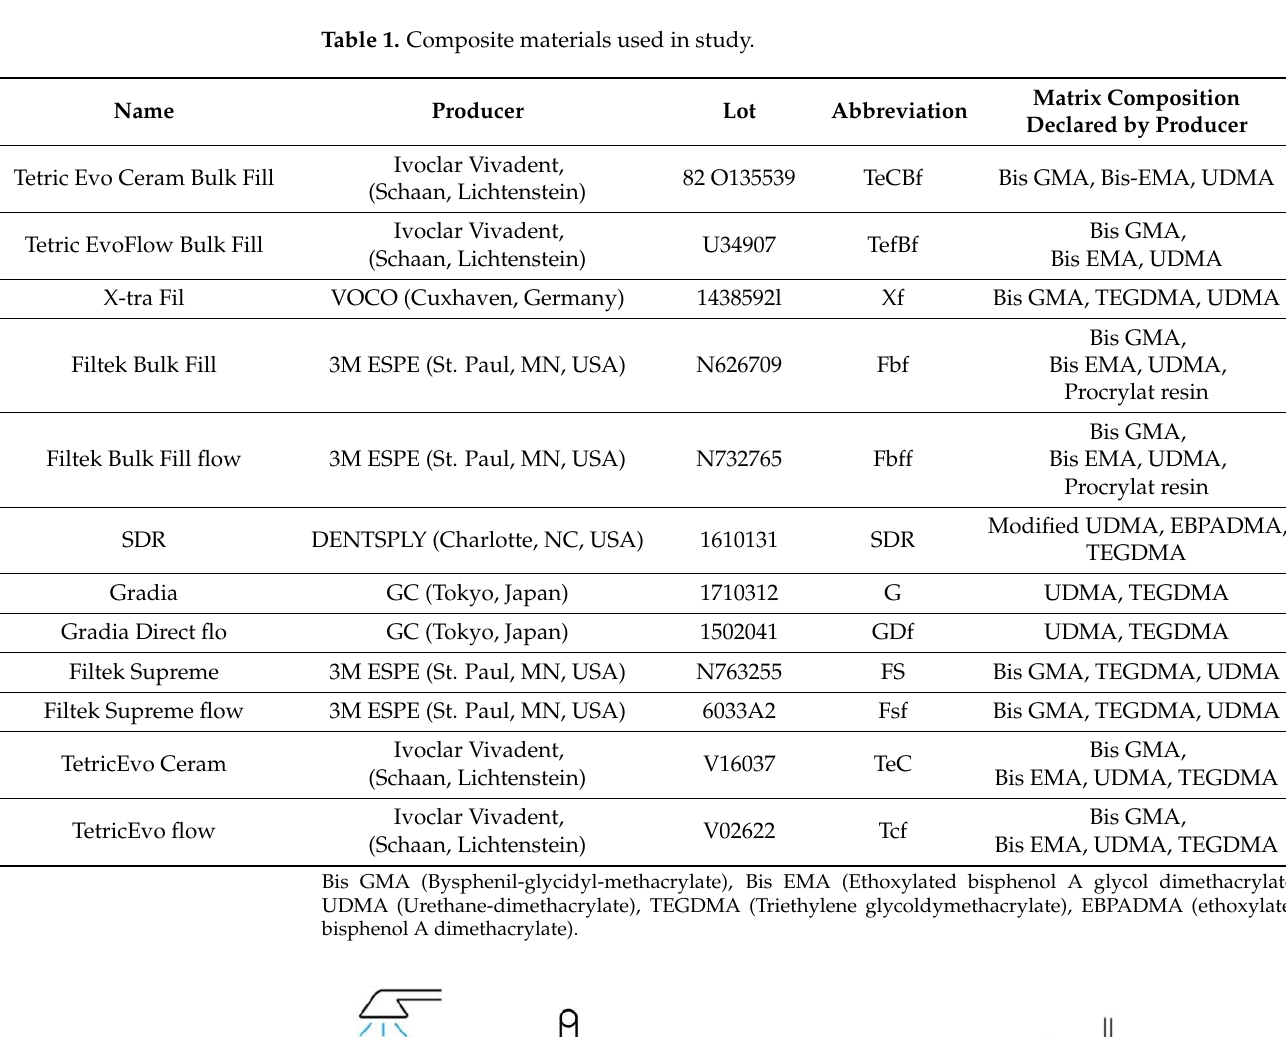
Table 1. Composite materials used in study.